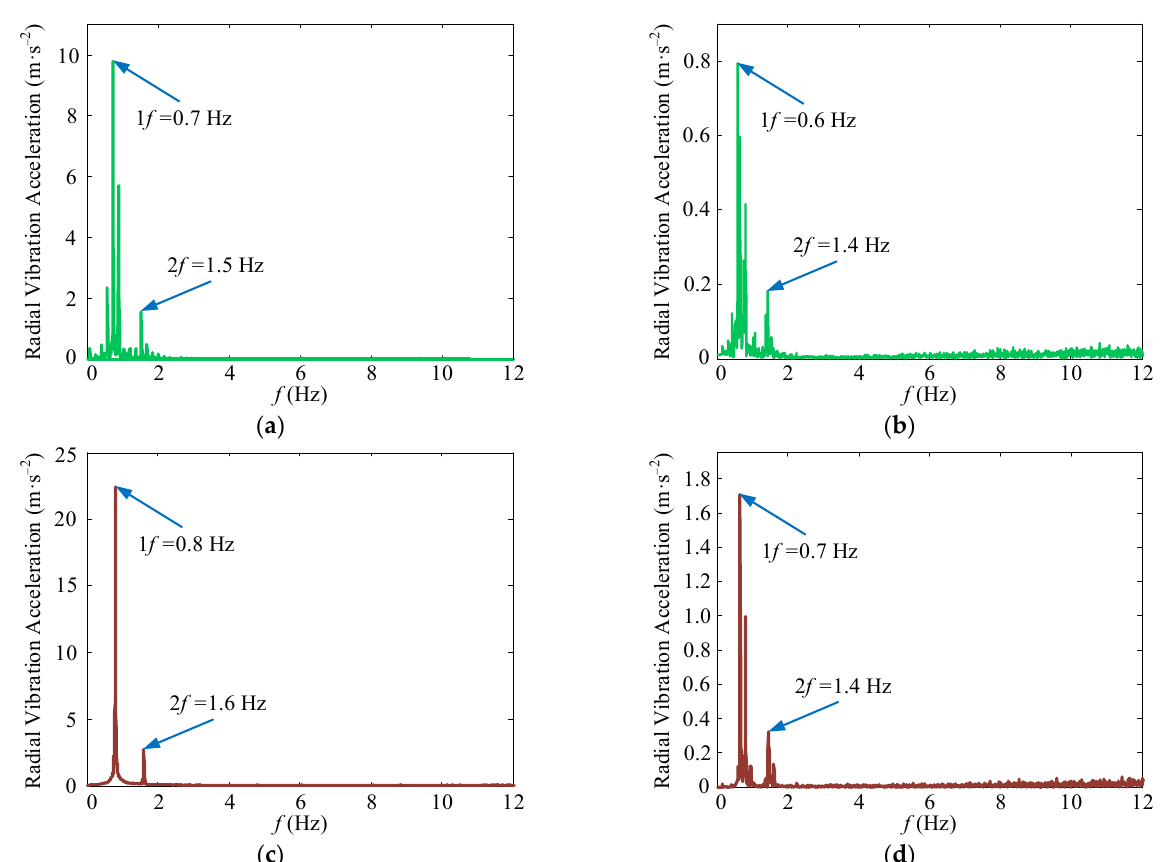
Figure 11. Vibration response of DGB 6205 system in the frequency domain: ( a ) X -direction frequency domain vibration response under time-varying load, ( b ) Y -direction frequency domain vibration response under time-varying load, ( c ) X -direction frequency domain vibration response under constant load, and ( d ) Y -direction frequency domain vibration response under constant load.